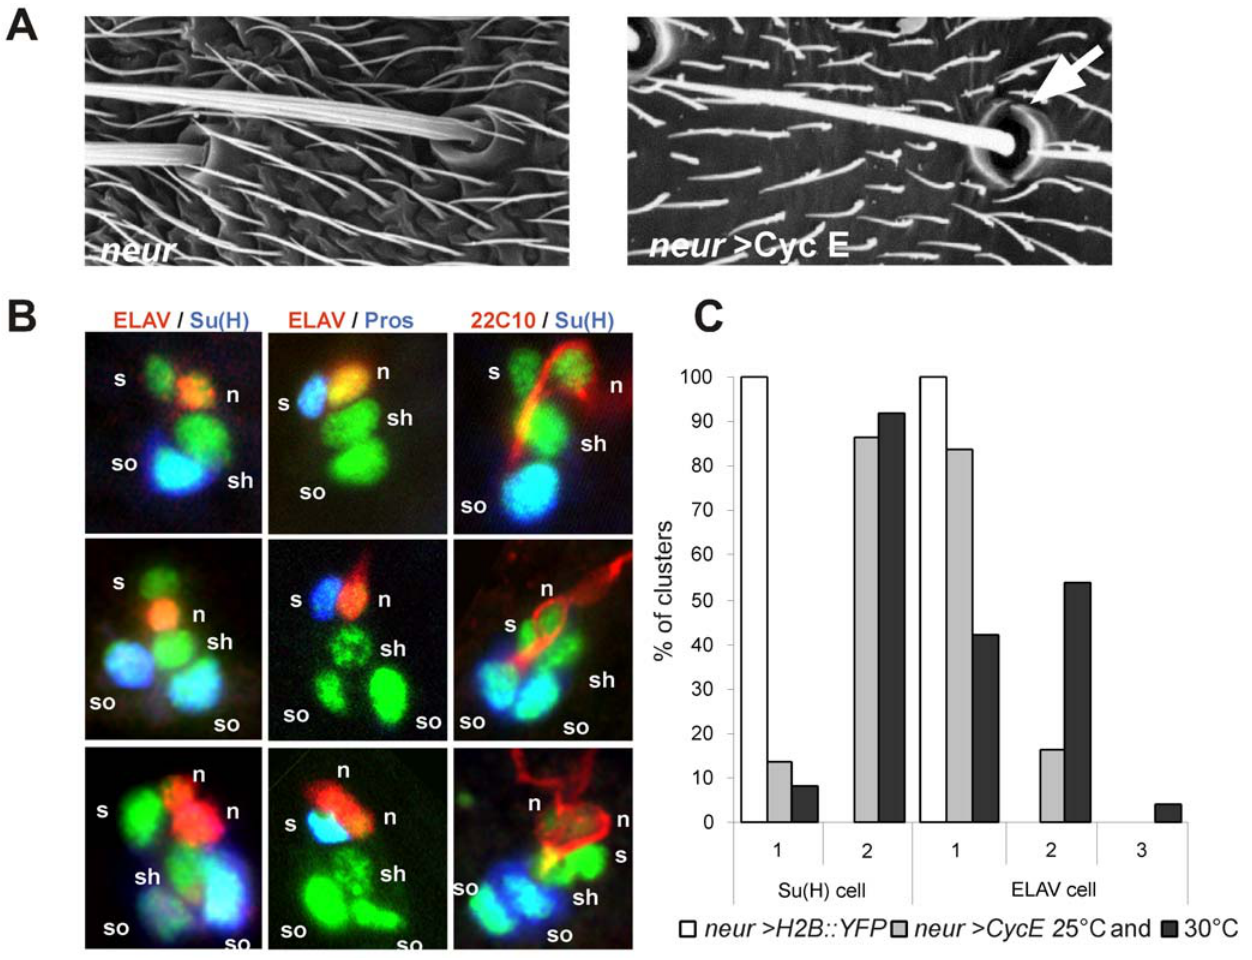
Figure 2. Extra socket cells and neurons are observed when CycE is overexpressed in the bristle lineage. (A) Scanning electron micrograph showing mechanosensory bristles of neur (left) and neur . CycE (right) flies. The arrow indicates duplicated socket cells observed after CycE overexpression. (B) Different types of sensory organs in neur . CycE , H2B::YFP pupae at 28 h APF. Sensory cells are in green (GFP staining). Socket cells are detected by their specific accumulation of Su(H) (blue in left and right panels), the sheath cells by Pros immunoreactivity (blue in middle panels) and neurons by ELAV (red in left and middle panels) and 22C10 immunoreactivity (red in right panels). n: neuron; s: sheath cell; sh: shaft cell; so: socket cell. (C) Quantification of the phenotype obtained after CycE overexpression. Histogram shows the percentage of clusters harbouring one or two socket cells and one, two or three neurons in wild type (white bars) or neur . CycE at 25 u C (grey bars) and 30 u C (black bars).